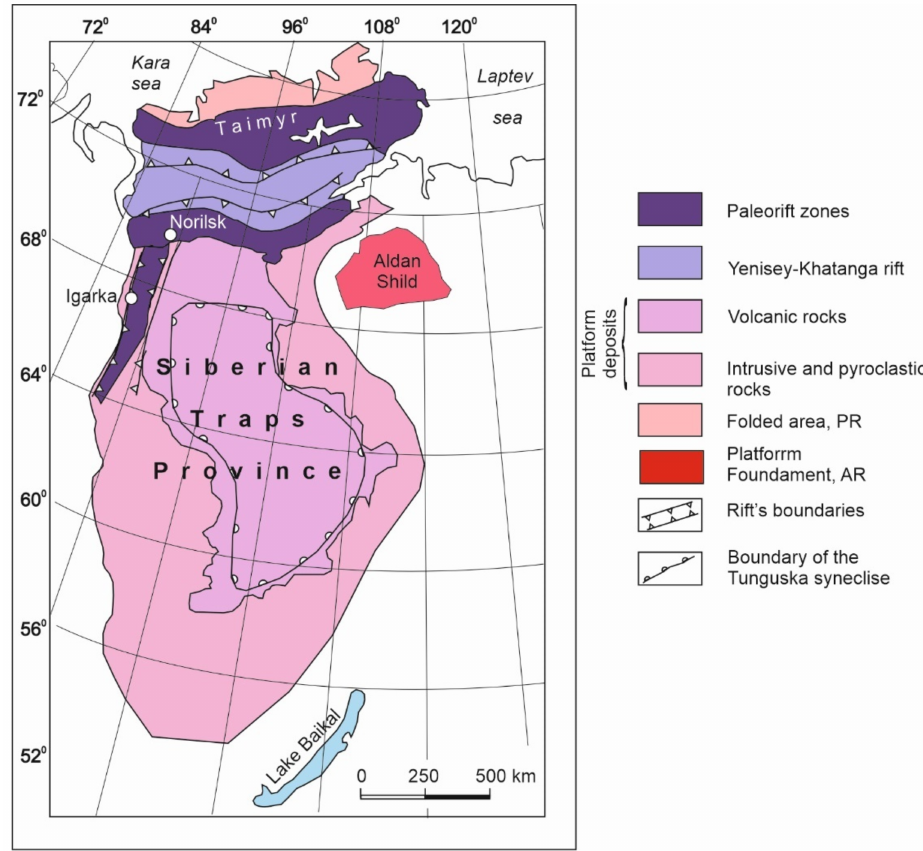
Figure 1. Tectonic scheme of eastern Siberia (after [35], with the authors’